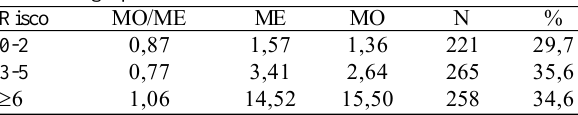
Tabela 4. Porcentagens da mortalidade observada e estimada por